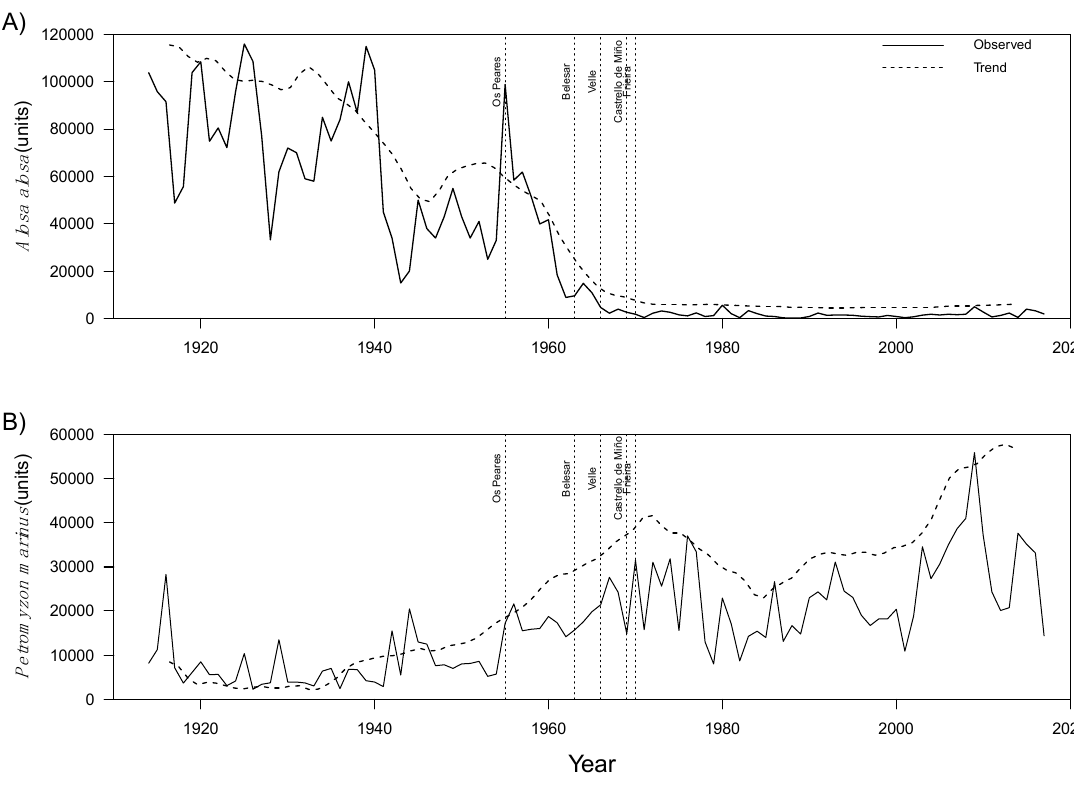
Figure 2. Capture data of Alosa alosa ( A ) and Petromyzon marinus ( B ). The observed trends decomposed with time series Differencing Methods are also shown, as well as the dates when the main dams were constructed.